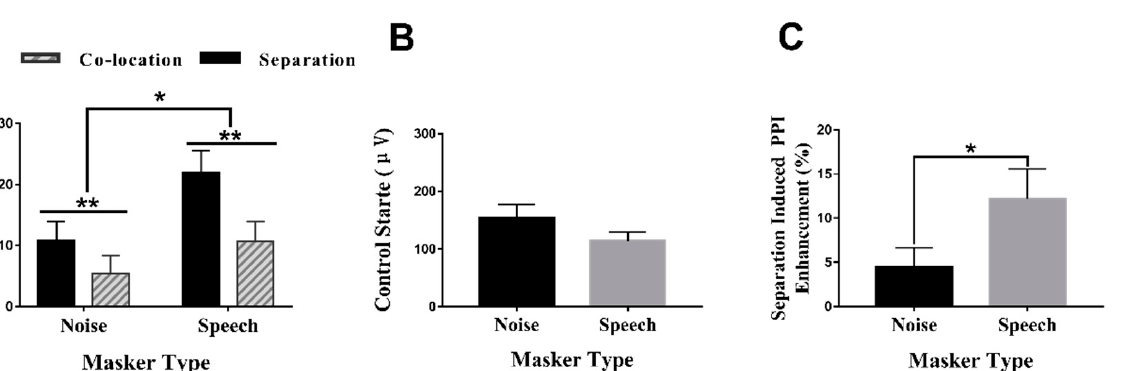
Figure 4. ERPs evoked by the prepulse. ( A – C ) Comparisons of the group-mean N1, P2, and N1P2 peak-to-peak amplitudes recorded at the sites near the frontoparietal cortex under the four conditions. ( D , E ) The mean latencies of the N1 and P2 components under the four conditions. Data are expressed using mean ± SEM; *, p < 0.05; **, p < 0.01; ***, p < 0.001.